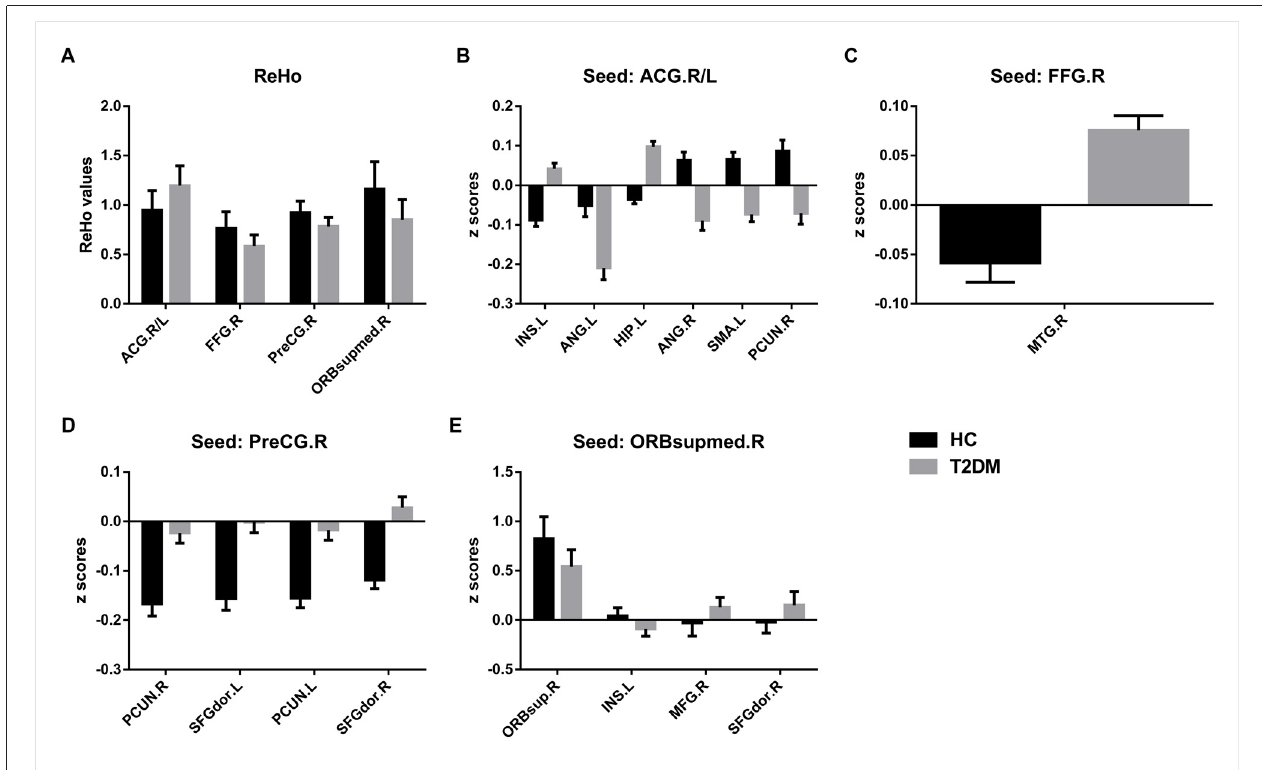
FIGURE 2 | Brain regions with significant differences in ReHo (A) and FC (B–E) between Type 2 diabetes mellitus (T2DM) patients and healthy controls. Voxel p < 0.005 (AlphaSim correction, cluster p < 0.01, cluster size > 16 voxels). ACG, anterior cingulate gyrus; FFG, fusiform gyrus; PreCG, precentral gyrus; ORBsupmed, superior frontal gyrus, medial orbital; INS, insula; ANG, angular gyrus; HIP, hippocampus; SMA, supplementary motor area; PCUN, precuneus; MTG, middle temporal gyrus; SFGdor, superior frontal gyrus, dorsolateral; ORBsup, superior frontal gyrus, orbital part; MFG, middle frontal gyrus; R, Right; L,